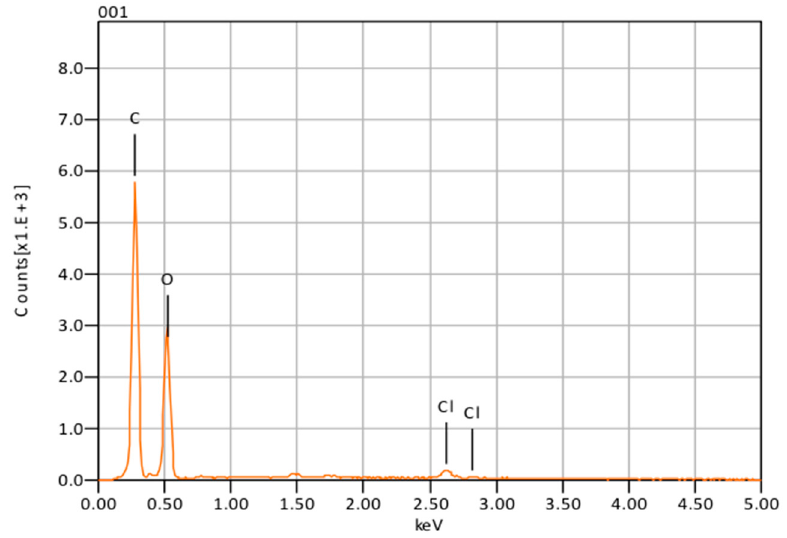
Figure 3. Nanoparticle composition obtained with energy dispersive X-ray spectroscopy (EDS).